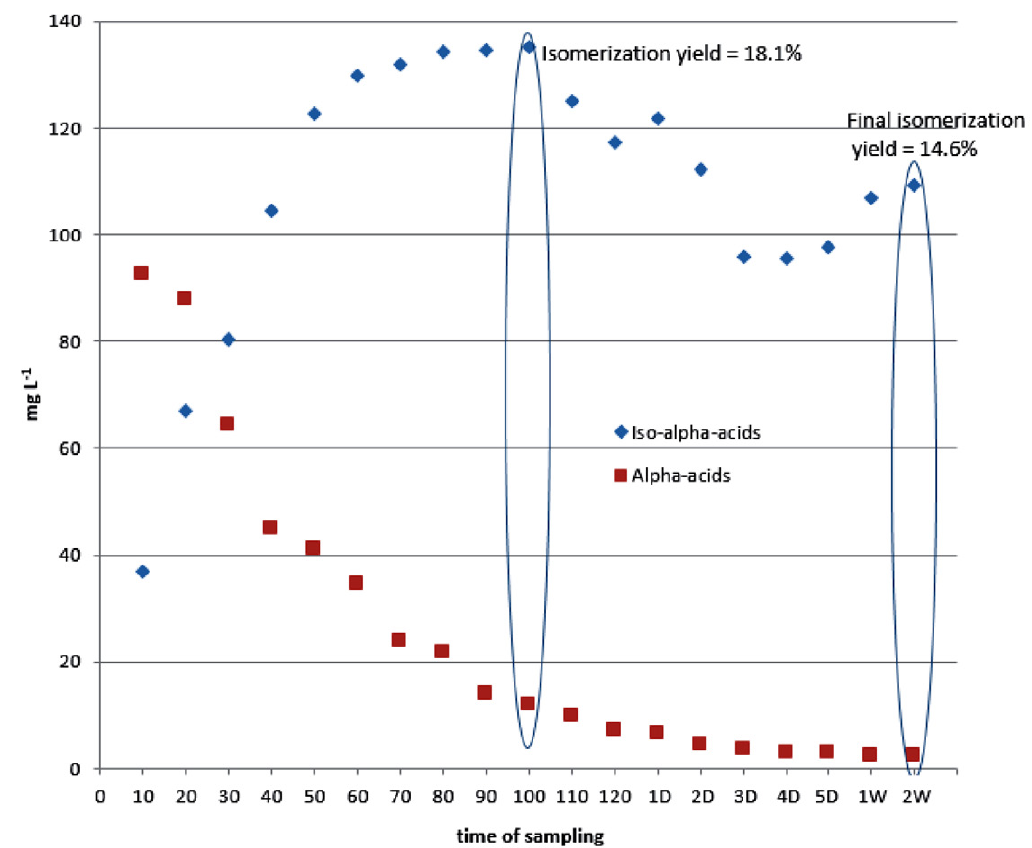
Figure 1: Dynamic of isomerization of alpha-acids in beer B. Sampling was made every 10 min during boiling, every day of fermentation and every week of maturation.